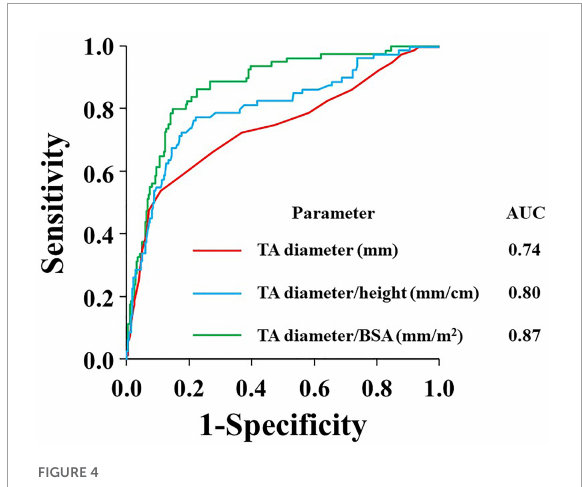
FIGURE4 ROC curves for the prediction of significant TR according to absolute TA diameter (red), TA diameter/height (blue), and TA diameter/BSA (green). AUC, area under the curve; BSA, body surface area; TA, tricuspid annulus; and TR, tricuspid